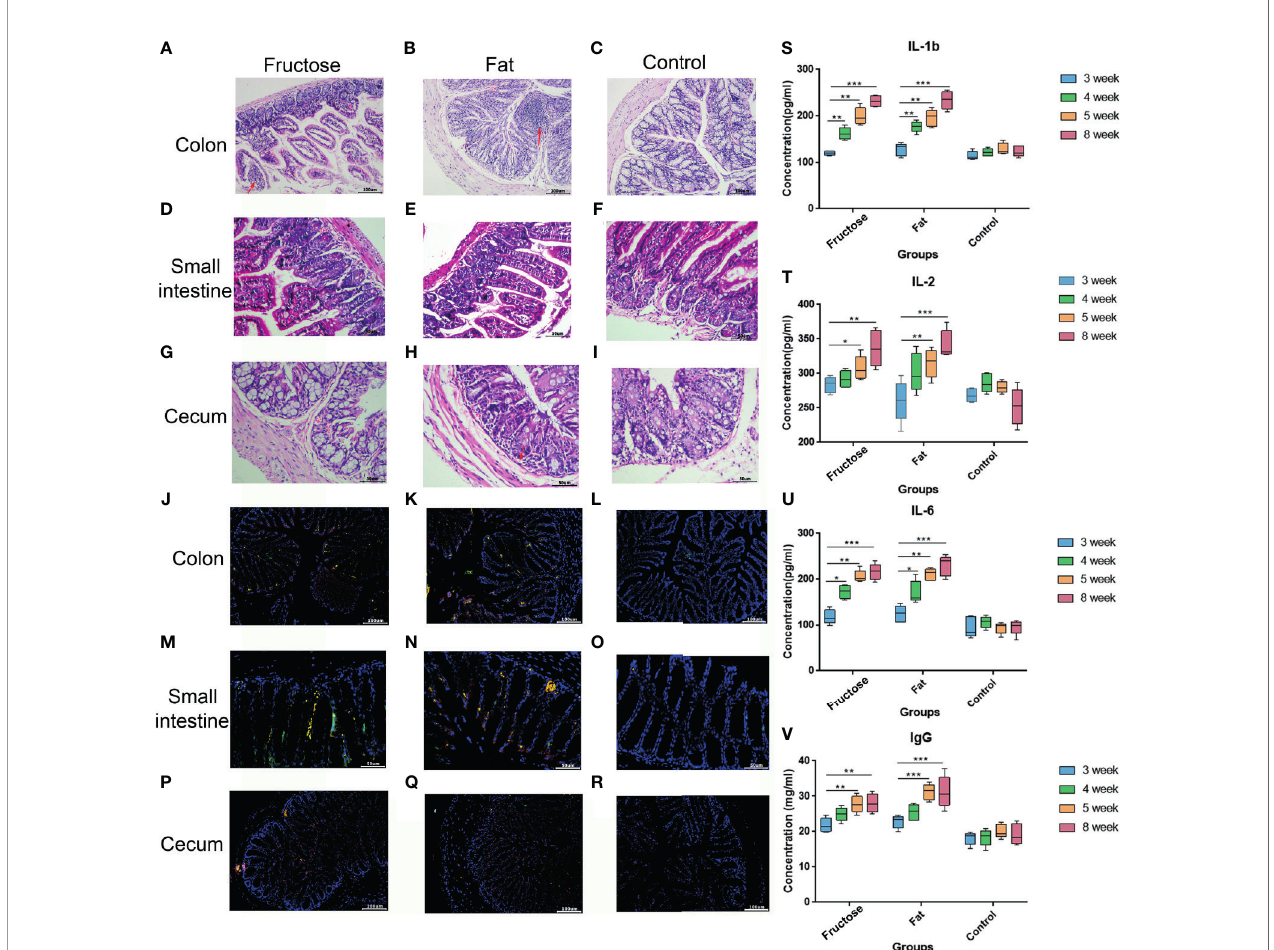
FIGURE 2 | Effects of high-fructose and high-fat diets on intestinal in fl ammation. The colon pathological sections were from the high-fructose group (A, J) , the high-fat group (B, K) and the control group (C, L) . The small intestine pathological sections were from the high-fructose group (D, M) , the high-fat group (E, N) and the control group (F, O) . The cecum pathological sections were from the high-fructose group (G, P) , the high-fat group (H, Q) , and the control group (I, R) . In H&E staining images, the nucleus is blue and the cytoplasm is red; the red arrow indicates in fl ammatory cell in fi ltration. In the immuno fl uorescence staining images, the nuclei stained by DAPI are blue under UV excitation, the cells labeled for CD3 are red, and those labeled for CD4 are green. Cells expressing both CD3 and CD4 appear yellow after superimposition. The levels of IL-1 b (S) , IL-2 (T) , IL-6 (U) , and IgG (V) were measured from the 3rd week to the 8th week. (*p < 0.05, **p < 0.01, ***p <